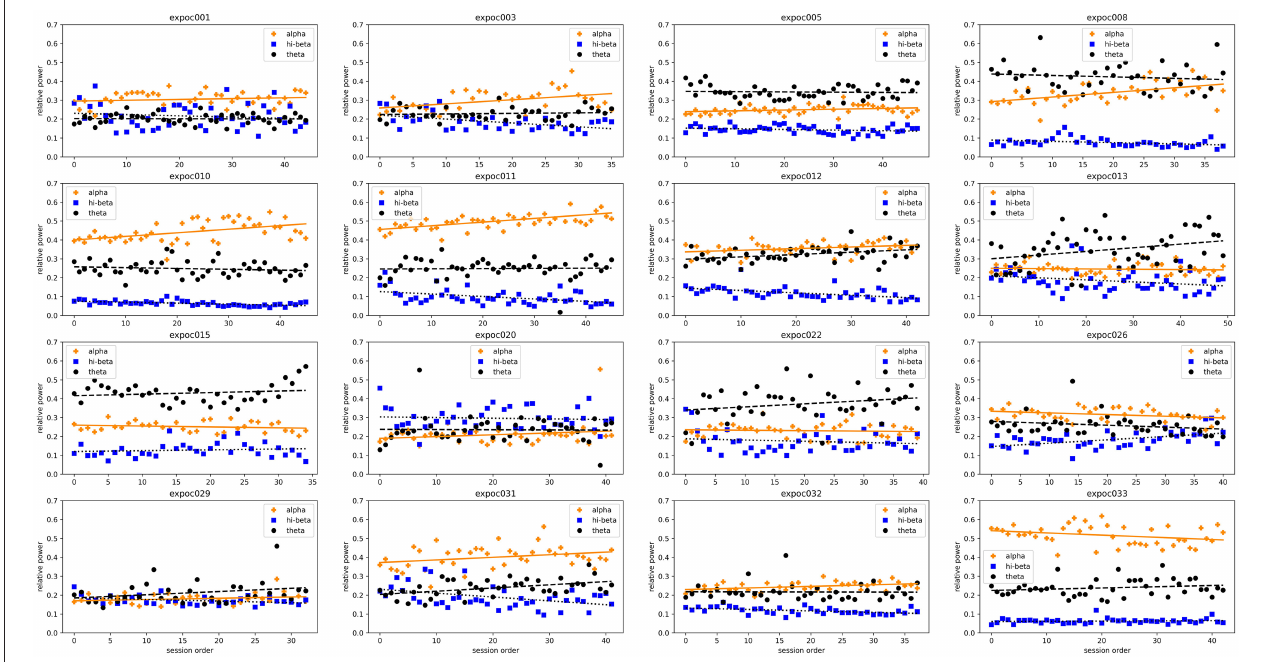
FIGURE 10 | Trends in resting-state relative alpha, hi-beta and theta of each individual patient at each neurofeedback training session.